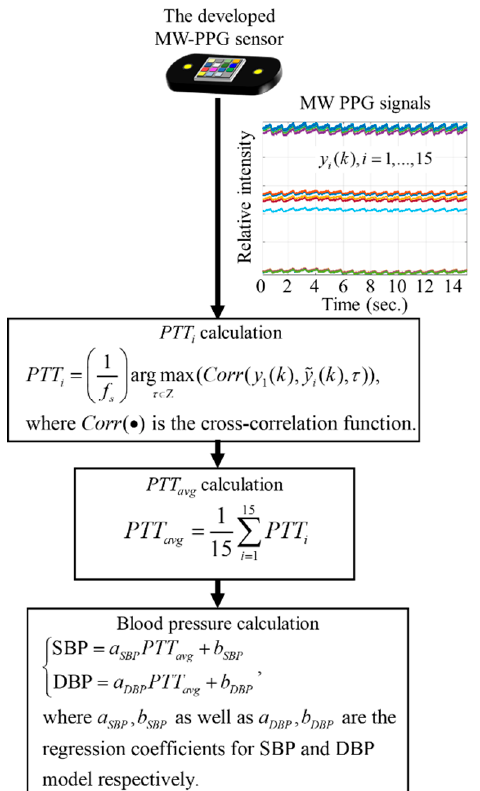
Figure 5. Signal processing procedure of blood pressure measurement using the MW-PPG sensor Figure5. developed.